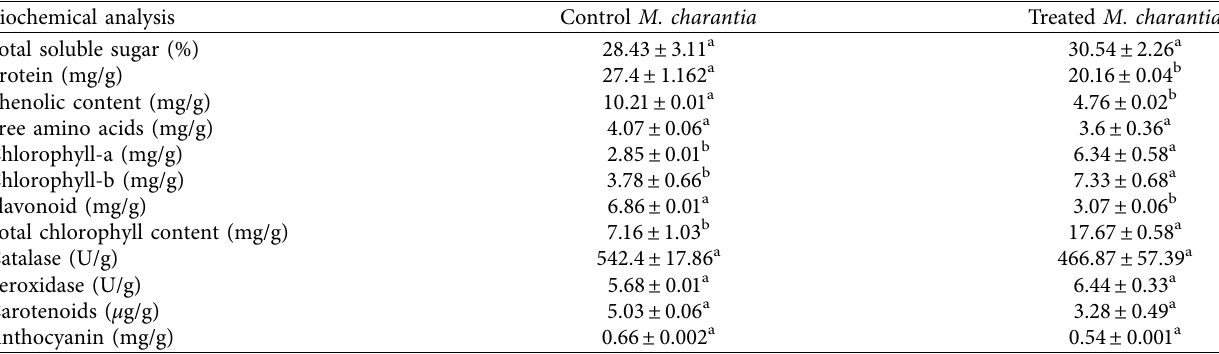
Table 1: Biochemical analysis of zinc sulfate treatment on seed priming of M. charantia at biochemical attributes of vegetative tissues in leaves.